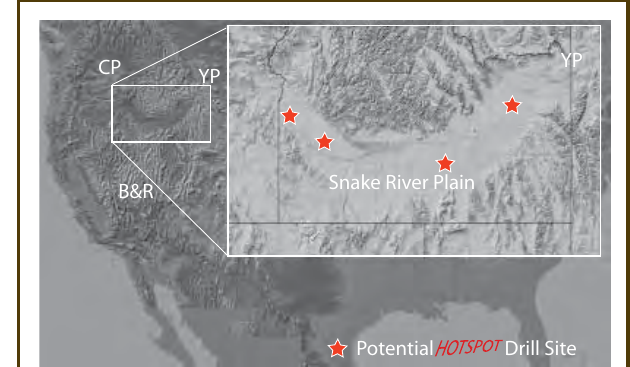
Figure 1. Digital elevation model of southern Idaho showing Snake River Plain and its relation to fl ood basalts of Columbia Plateau in Washington and Oregon (CP), Basin & Range area (B&R), and Yellowstone plateau (YP). Potential drilling sites are shown as red